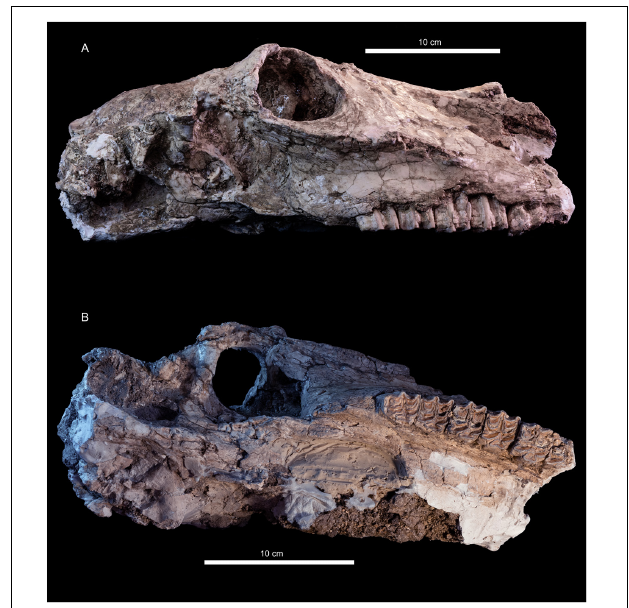
shallow, it is not pocketed posteriorly, the edges are poorly defined and the infraorbital foramen is included in the anterior part. (B) MPGJ 1683, ventral view of P3-M3, we observed the protocone with small anterior heel and P4-M1 the lingual edge is